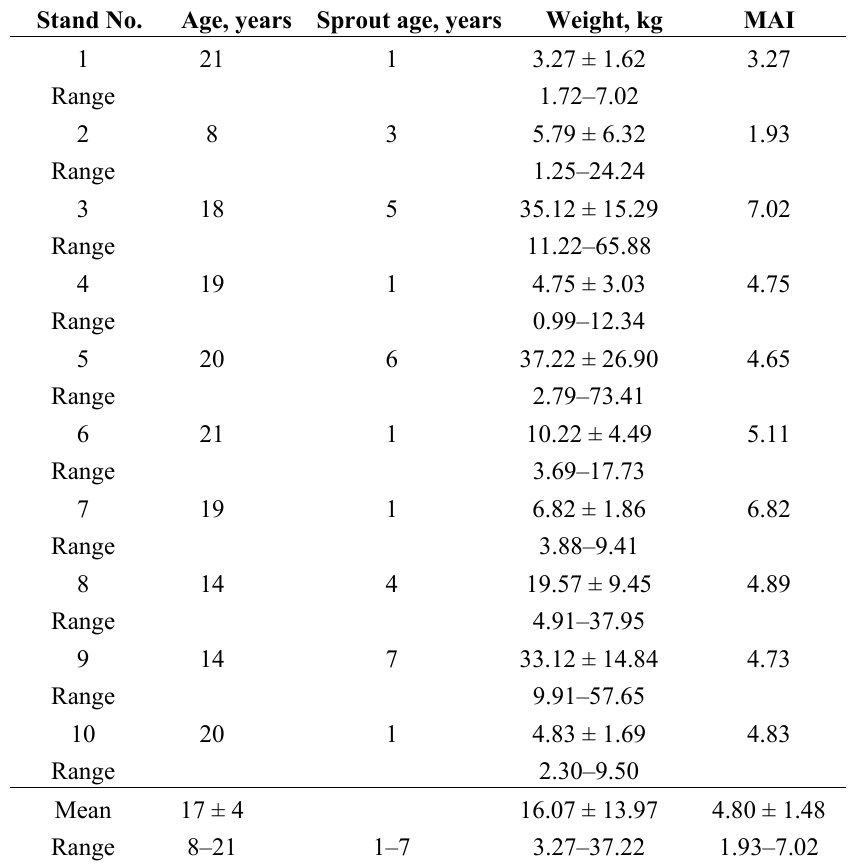
Table 4. Mean and range of dry mass (kg) and MAI of sprouts per living stump. Stand No.